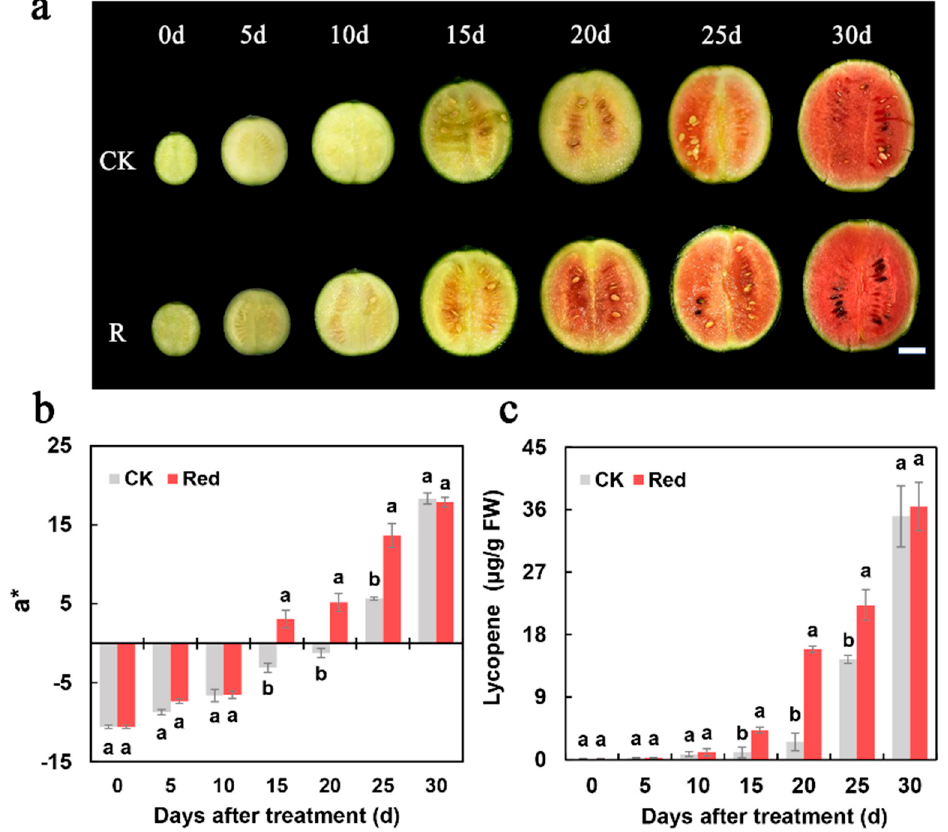
Figure 1. Flesh color and lycopene content in watermelon flesh after supplementary red lighting. ( a ) Flesh color of watermelon fruit during the fruit development stage (5 d, 10 d, 15 d, 20 d, 25 d, and 30 d after supplementary red lighting and natural light treatments). ( b ) Color difference analysis of flesh color using a chromatic aberration meter. ( c ) Lycopene content in watermelon fruit. Red: supplementary red lighting; CK: natural light (control). The data show mean values of three replicates ( ± SD) no less than three plants per replicate. The mean values of different letters were significantly different ( p < 0.05). Scale bar: 3 cm.